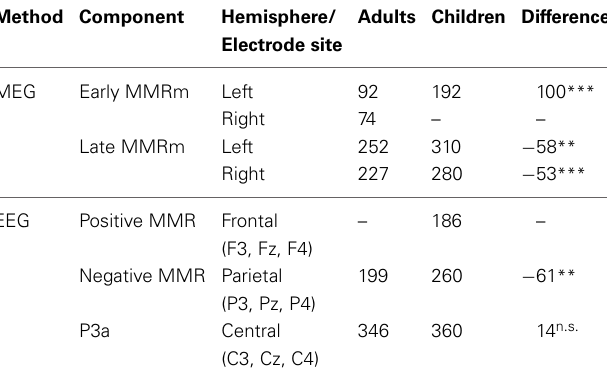
Table 2 | Estimated peak latencies of analyzed components (in